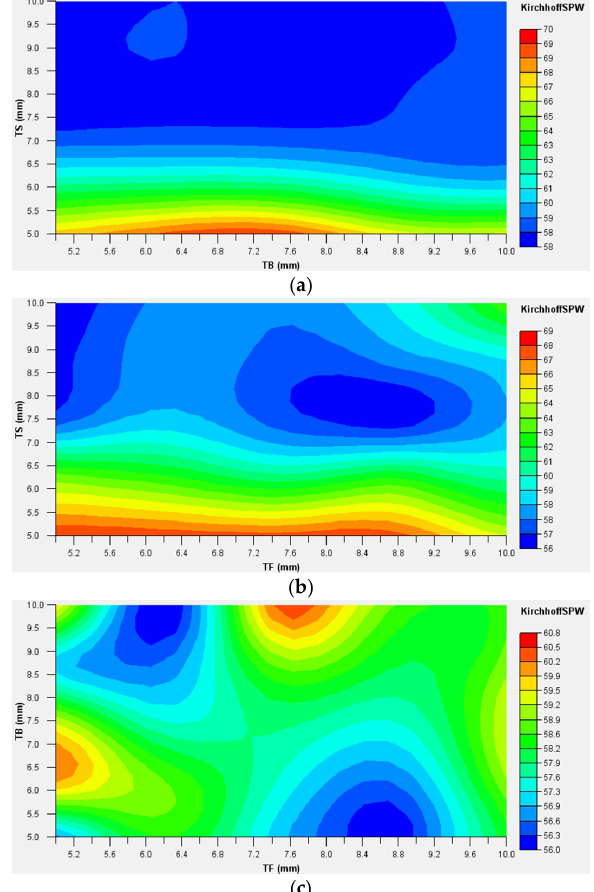
Figure 26. The relationship between each panel thickness (BT–ST; FT–ST; FT–BT) and radiated sound power of volute surface. ( a ) BT-ST; ( b ) FT-ST; ( c ) FT-BT. power of volute surface. ( a ) BT-ST; ( b ) FT-ST; ( c )